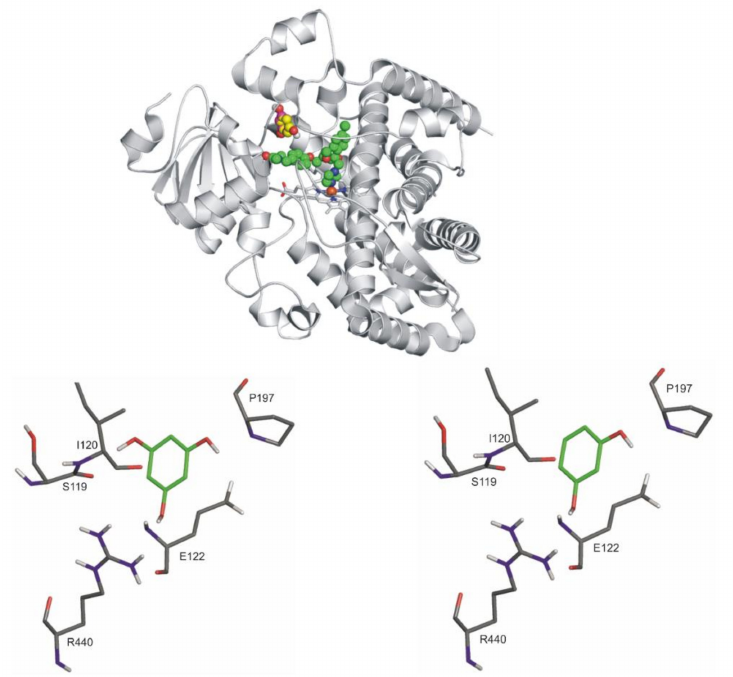
Figure 10. Top: The binding mode of ketoconazole (space-filling, green) superimposed from the crystallographic image (PDB code 2v0m) and the ligands, PHLO and RES (space filling, yellow, and pink, respectively) as docked to the binding pocket of CYP3A4 enzyme (teal cartoon) above the heme ring (teal sticks, iron with orange sphere). Notably, the binding positions of PHLO and RES overlap significantly; therefore, they cannot be demonstrated separately. Bottom, left: The close-up of binding mode of PHLO (green sticks) as docked to the binding pocket of CYP3A4 enzyme. Interacting enzyme residues are labelled and shown as thin sticks. Bottom, right: The close-up of binding mode of RES (green sticks) as docked to the binding pocket of CYP3A4 enzyme. Interacting enzyme residues are labeled and shown as thin sticks. Interacting amino acids (both RES and PHLO): N104, R105, R106, P107, F108, S119, I120, A121, E122, and R440; binding energies: − 6.26 kcal / mol (RES) and − 6.46 kcal / mol